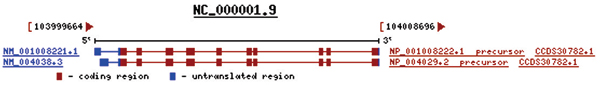
Gene Structure. Gene structure of the Human gene 276 located in chromosome 1: The boxes correspond to the exons (coding regions), and the lines between them represent the introns (non-coding regions). The total length of the gene is N = 8208 bases, including 1536 coding bases and 6672 non-coding bases.